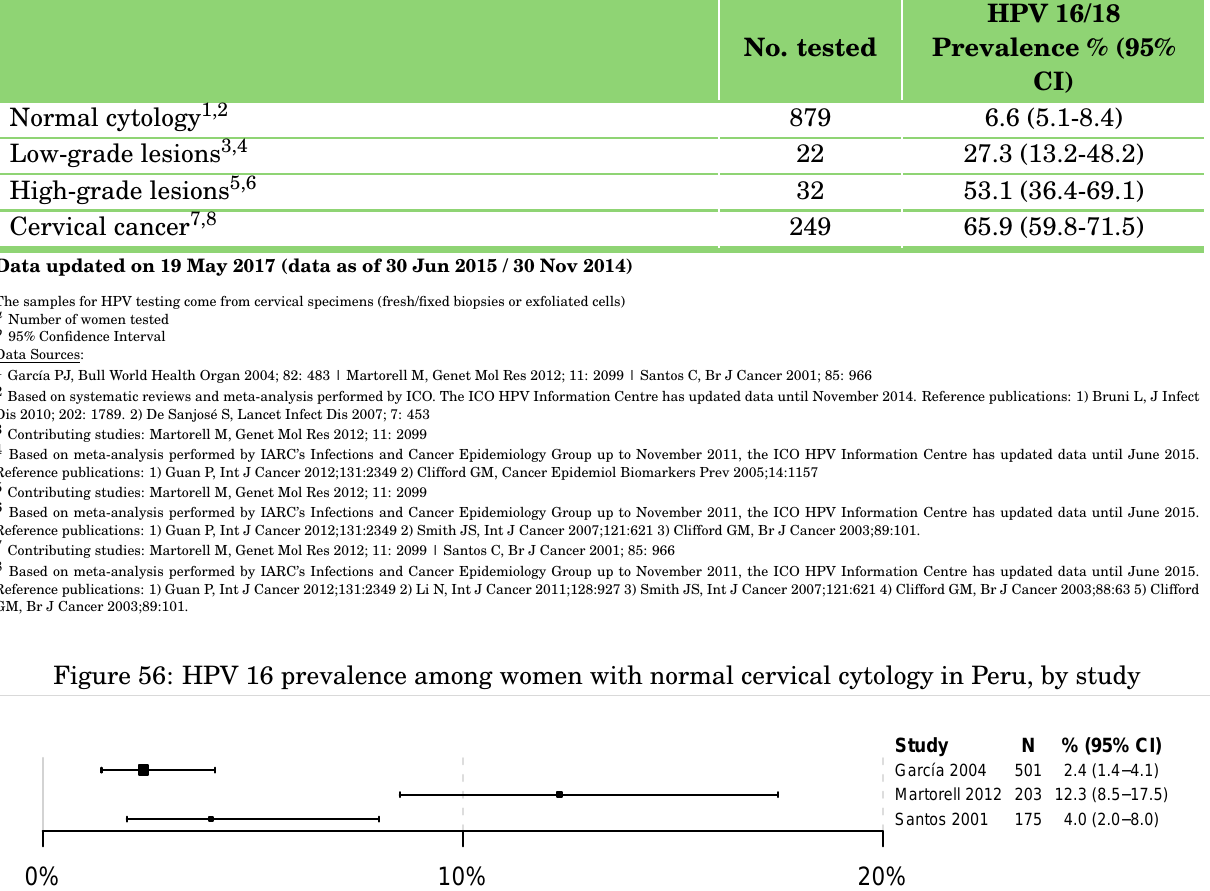
Table 21: Prevalence of HPV16 and HPV18 by cytology in Peru